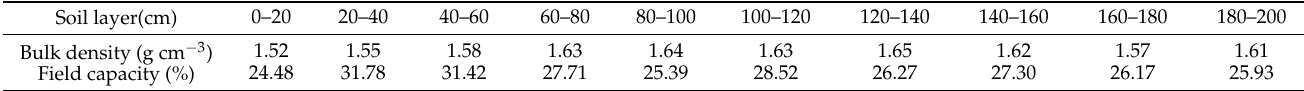
Figure 1. Rainfall and daily mean air temperature during the three growing seasons. Table 1. The soil bulk density and field capacity in 0–200 cm soil layers in the experimental plots. Soil